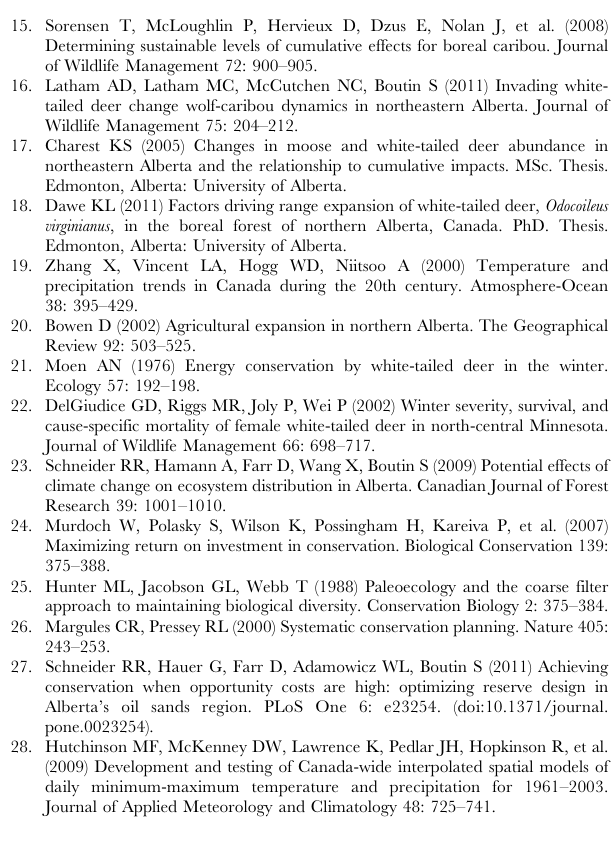
Figure S1 Density of linear features, by township. Figure S2 Probability of the presence of white-tailed deer, by township.